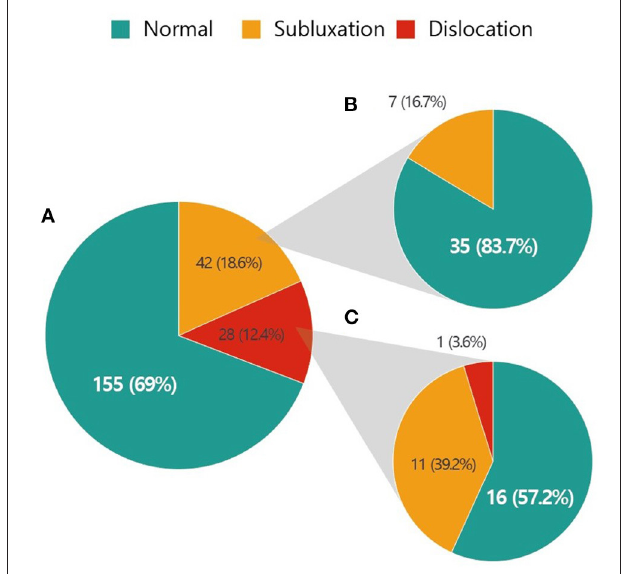
FIGURE 1 | Incidence of hip subluxation and dislocation in patients with mitochondrial disease and status of the hip at the initial assessment. (A) Number of patients with hip subluxation and dislocation. (B) Initial status of the hip in patients with hip subluxation. (C) Initial status of the hip in patients with hip